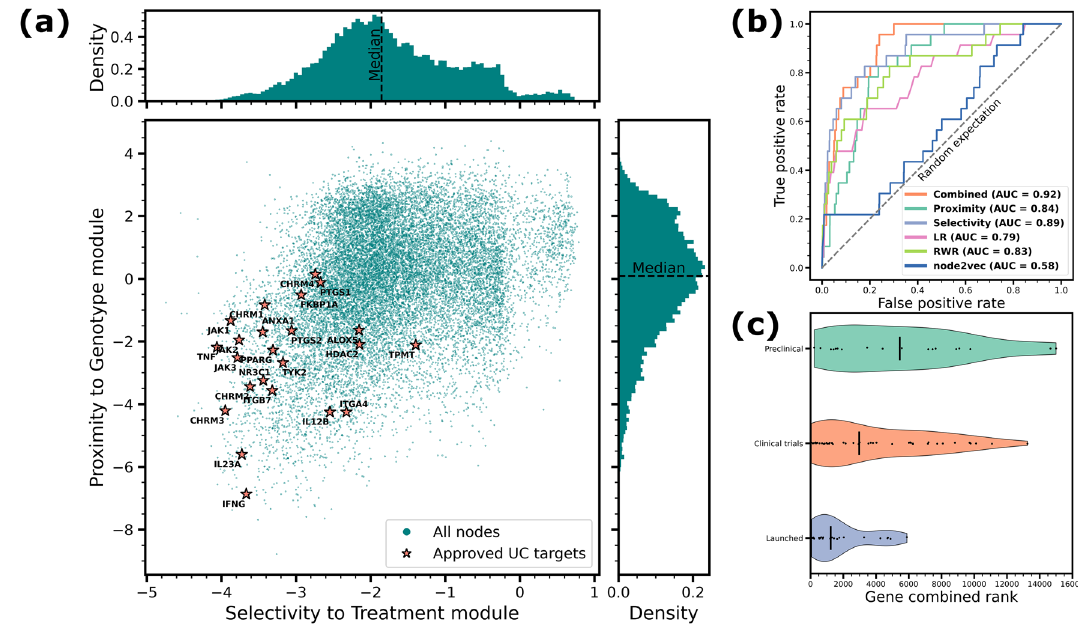
Figure 4. In silico validation of the module triad target prioritization. (a) Selectivity-proximity scatter plot of the HI nodes with 23 targets approved for UC treatment highlighted. More selective and proximal targets are located towards the lower left of the scatter plot. (b) Receiver operator characteristic (ROC) curves for recovery of the approved UC targets using proximity to the Genotype module, selectivity to the Treatment module, a combination of both, the Local radiality (LR) with respect to the Response module, random walk with restart (RWR) and node2vec embedding with respect to all UC disease associations, with corresponding areas under the curve (AUC). (c) Violin plots of the combined selectivity-proximity ranks of the targets launched for UC, and targets being at preclinical and clinical trials development stage for UC.